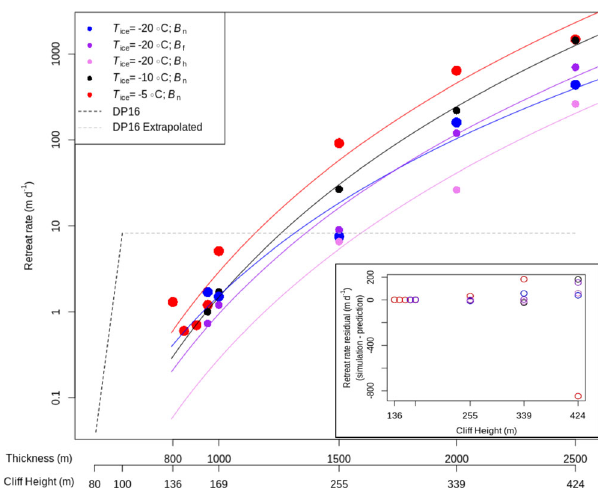
Fig. 2 Retreat rates resulting from ice-cliff failure as a function of glacier thickness or cliff height. Points represent results from the Elmer/ Ice – HiDEM be (the brittle-elastic version of the Helsinki Discrete Element Model) simulation series, which considers the interaction of viscous deformation and brittle failure. Scenarios with varying ice temperatures ( T ice ) and bed conditions ( B n , B f and B h representing normal, approaching frozen and high-slip conditions, respectively) are colour coded as follows: T = − 20 °C, B T = − 20 °C, B T = − 20 °C, B ice n (blue); ice f (purple); ice h (pink); T ice = − 10 °C, B n (black); T ice = − 5 °C, B n (red). Solid lines represent the fi tted power-law relationships as per Eq. (1). The dashed line represents retreat rates implemented in DeConto and Pollard 1 , with the light grey dashes denoting the maximum retreat rate implemented. Inset: Residuals of power-law fi t to retreat rates associated with simulated ice- cliff failure events, with color coding the same as the main